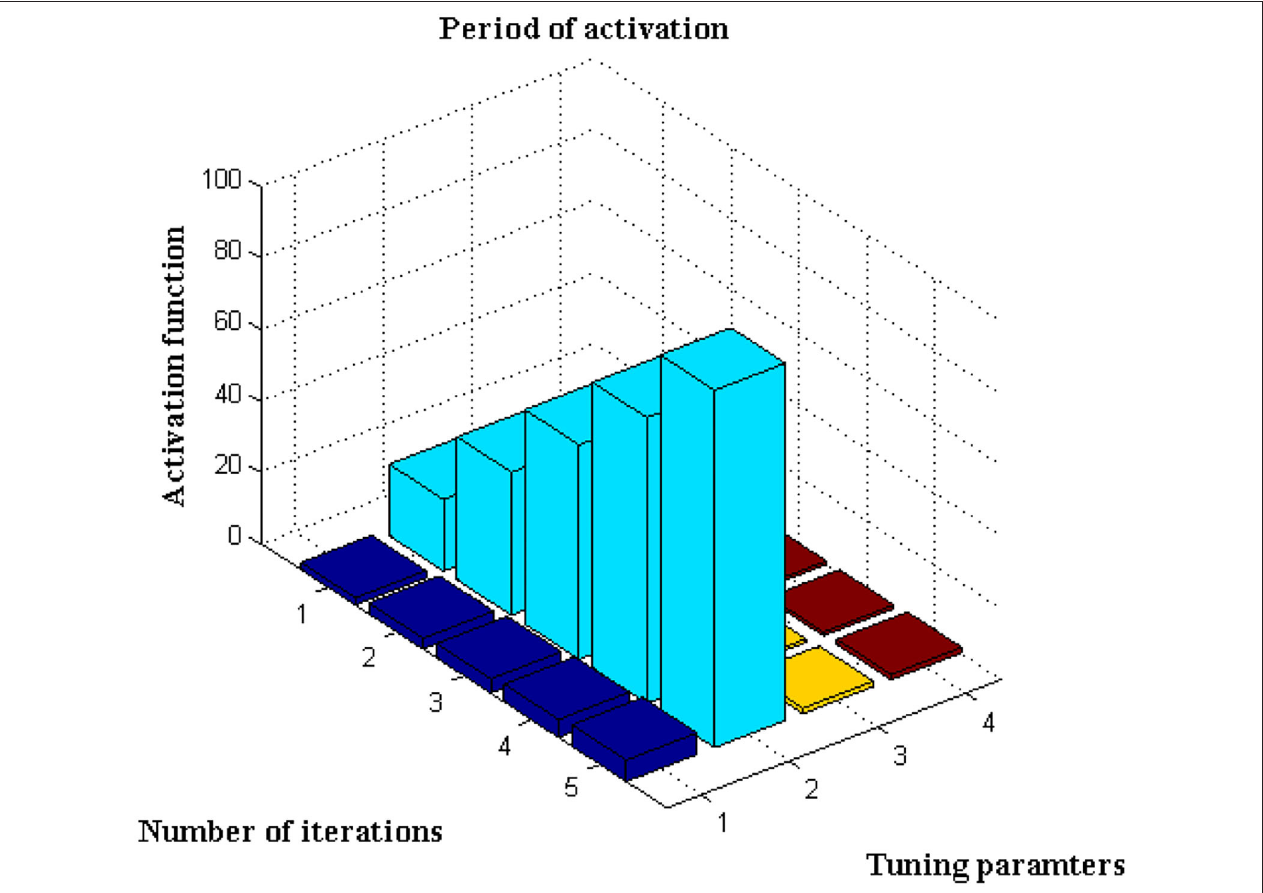
FIGURE 5 | Activation function with iteration periods.